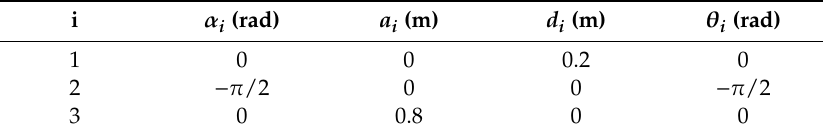
Table 2. The Denavit–Hartenberg parameters of the links.